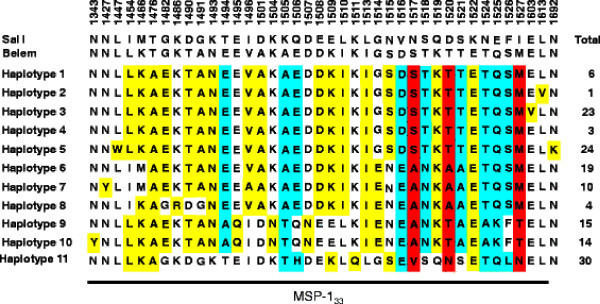
Sequence polymorphism of PvMSP-1 42 in Korean Plasmodium vivax isolates. Sequence analysis revealed that a total of 11 distinct haplotypes of PvMSP-142 were identified in 149 P. vivax Korean isolates. Polymorphic amino acids compared to the reference sequence, Sal I (AF435593), are listed for each haplotype. The dimorphic, trimorphic and tetramorphic amino acid changes are marked in yellow, blue and red, respectively. The total numbers of sequences for each haplotype are listed in the right panel.